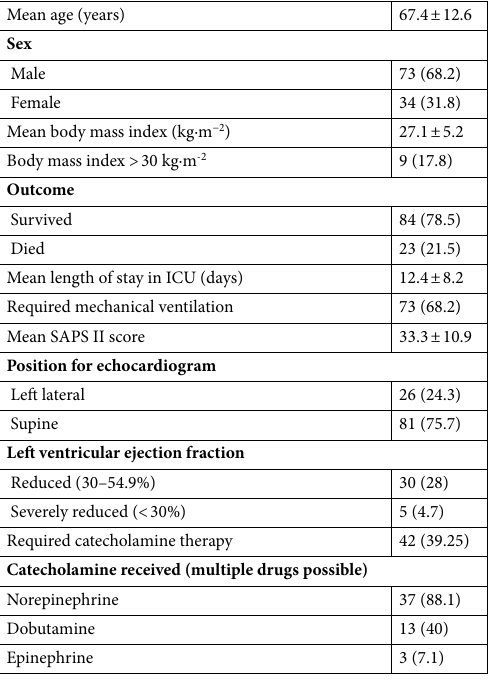
Table 1. Patient characteristics. Numerical variables are expressed as mean (± standard deviation), categorical variables as total number